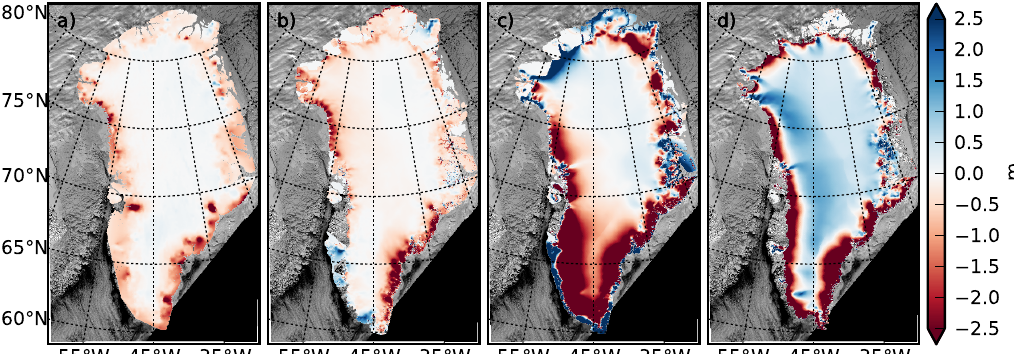
Fig. 7. Observed and modeled surface elevation change from October 2003 to November 2009 after subtracting the corresponding reference simulations. (a) ICESat (Sørensen et al., 2011). (b) “constant-climate” hindcast. (c) “paleo-climate” hindcast. (d) “flux-corrected” hindcast. Values are in